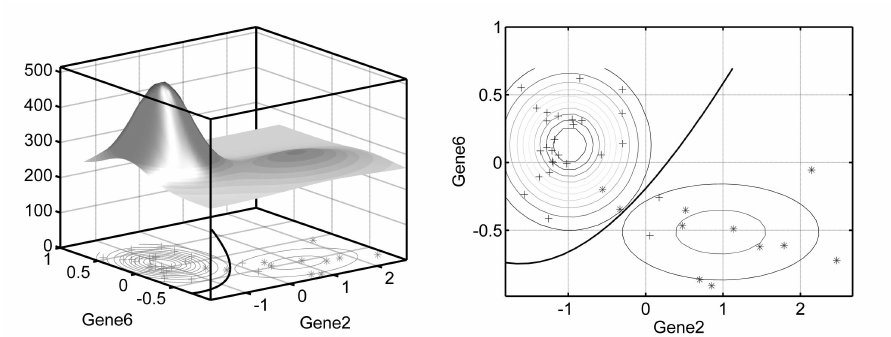
Figure 6. Uncorrelated (diagonal) DQDF; apparent error = 0.105, CV = 0.105 (SD < 0.001)